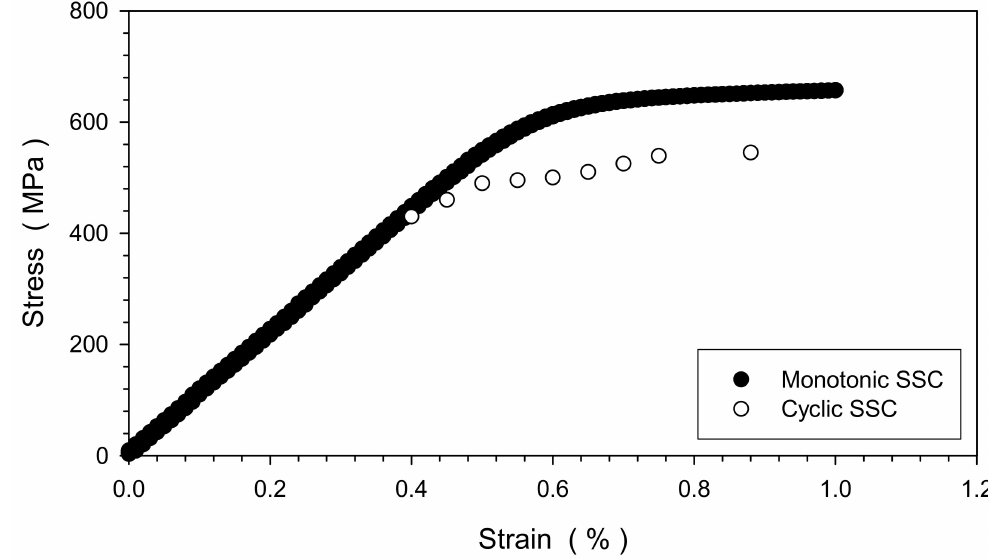
Figure 9. Stress–strain behaviour measured under monotonic (MSSC) and cyclic (CSSC) loading.